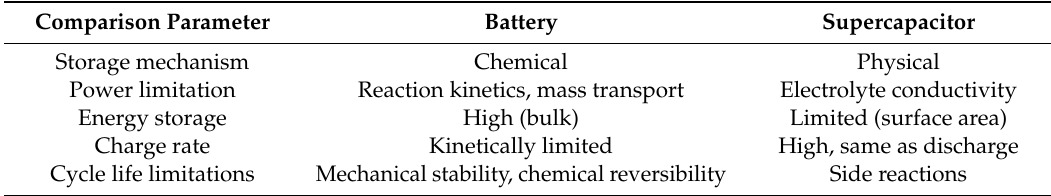
Table 4. Comparison between batteries and